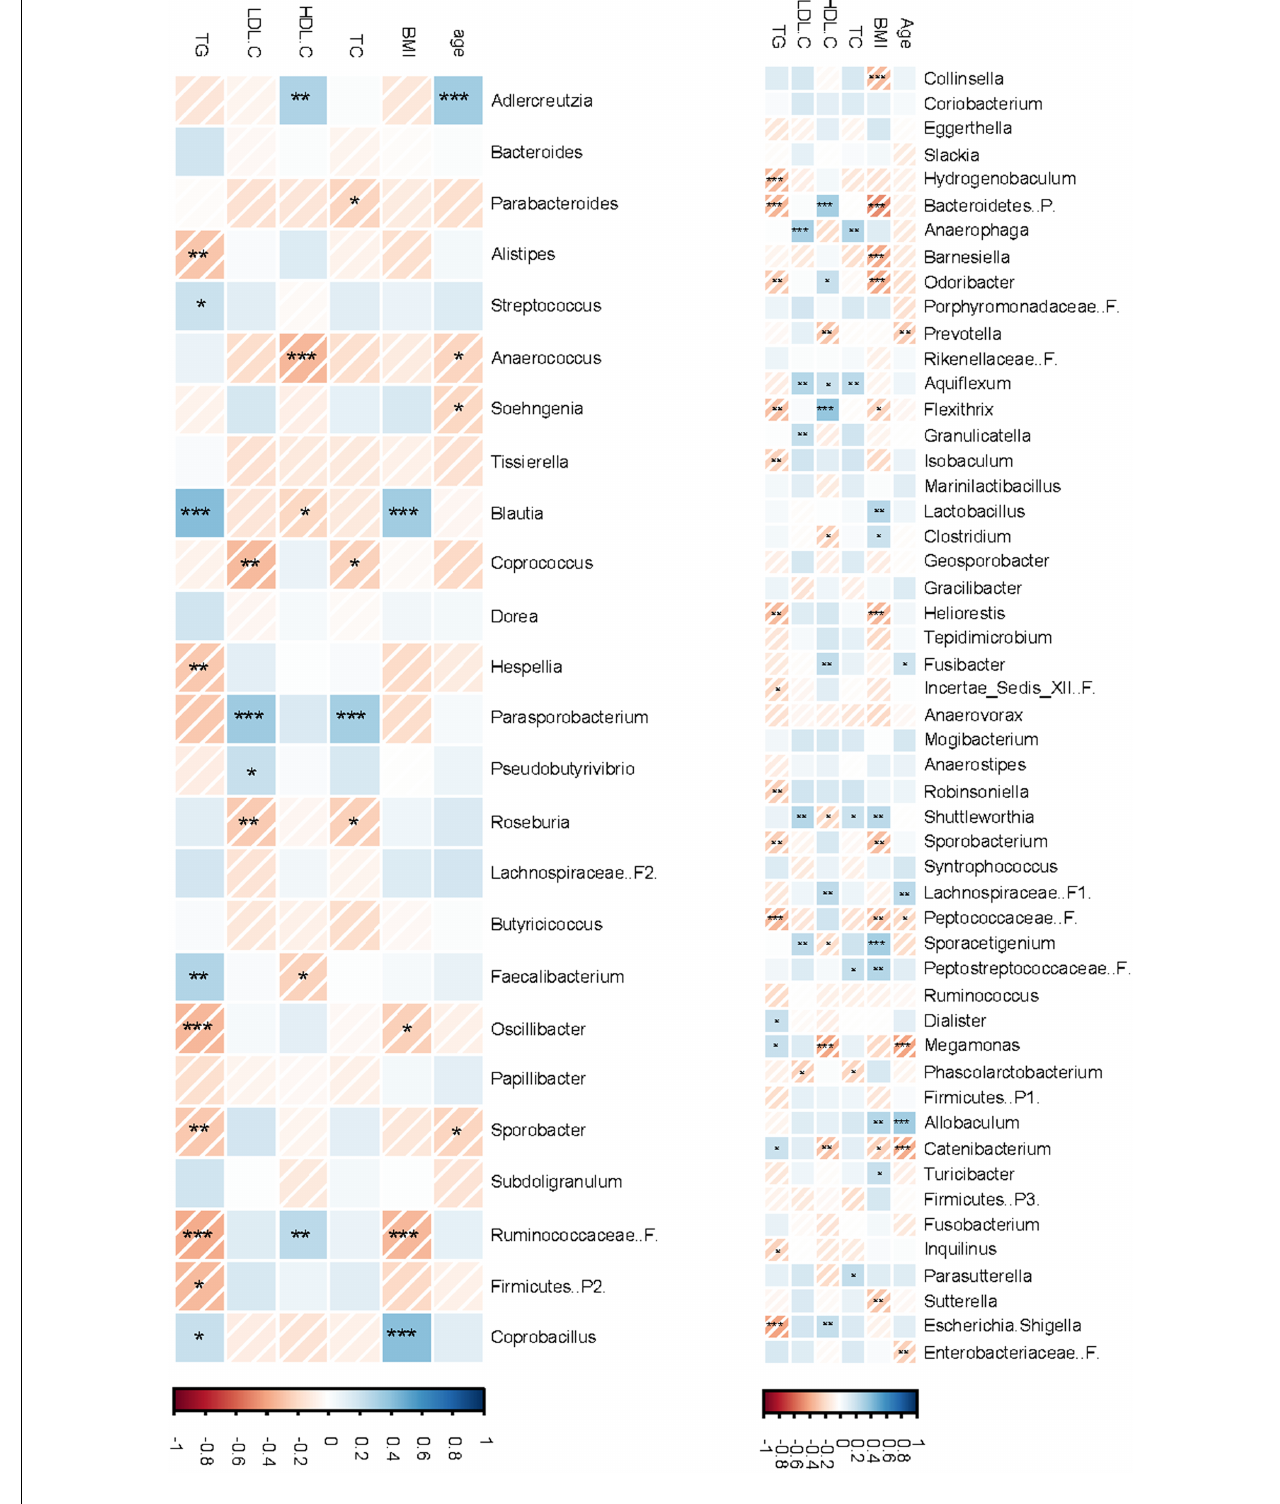
FIGURE 7 | Correlations between fecal microbiota compositions and serum lipid profiles. The non-parameteric Spearman correlation coefficient and P -values were presented in a heatmap format. Strong and weak correlations are presented by dark and light colors, respectively. The intensity bar shows positive and negative correlation from blue to red, respectively. ∗ P < 0.1; ∗∗ P < 0.05; ∗∗∗ P < 0.01. F.B, ratio of Firmicutes to Bacteroidetes.